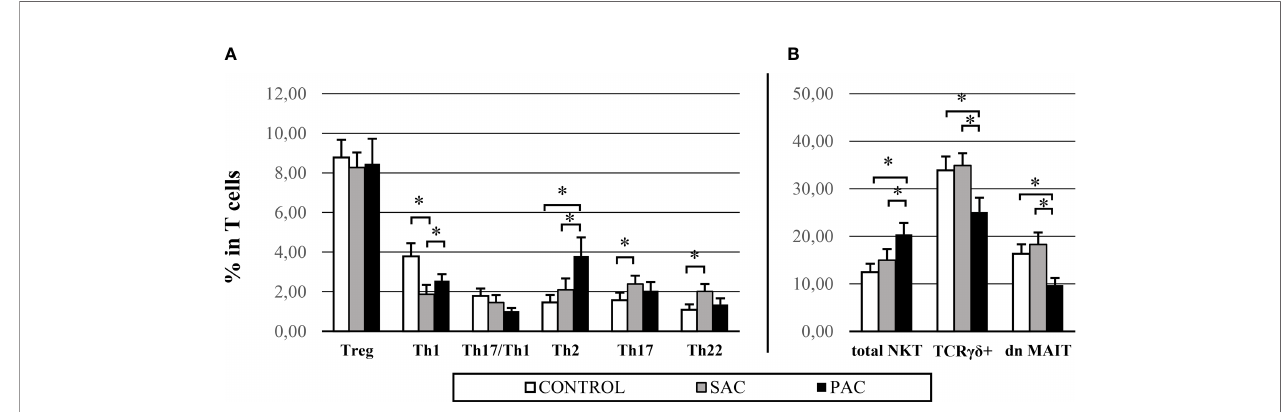
FIGURE 1 | Conjunctival IEL proportions – main differences in control, SAC and PAC groups. Graphs are divided into: CD4+ populations (A) and innate cells (B) . NKT = natural killer T cells. TCR gd + = gamma delta T cell receptor. dn MAIT= double negative mucosal associated invariant T cells. *p >